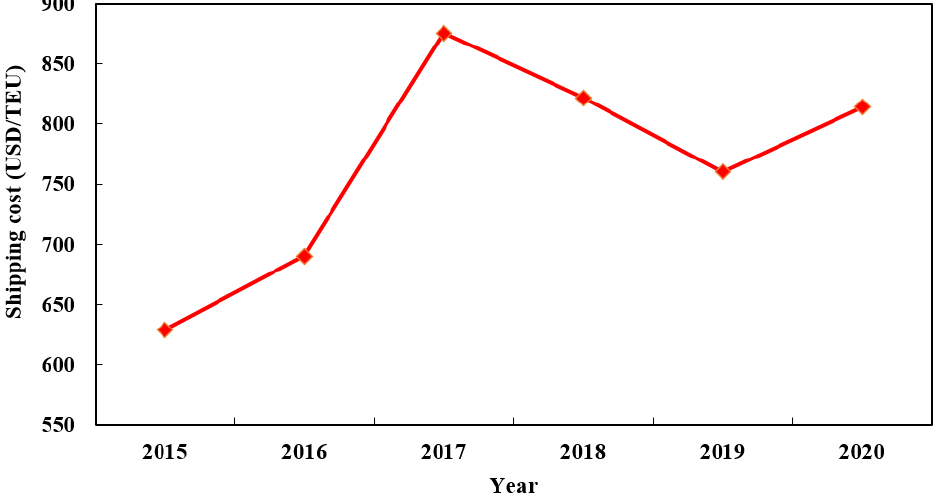
Figure 3. Shipping cost of 20-feet container freight in 2015–2020. Source: Compiled by the authors from [49].